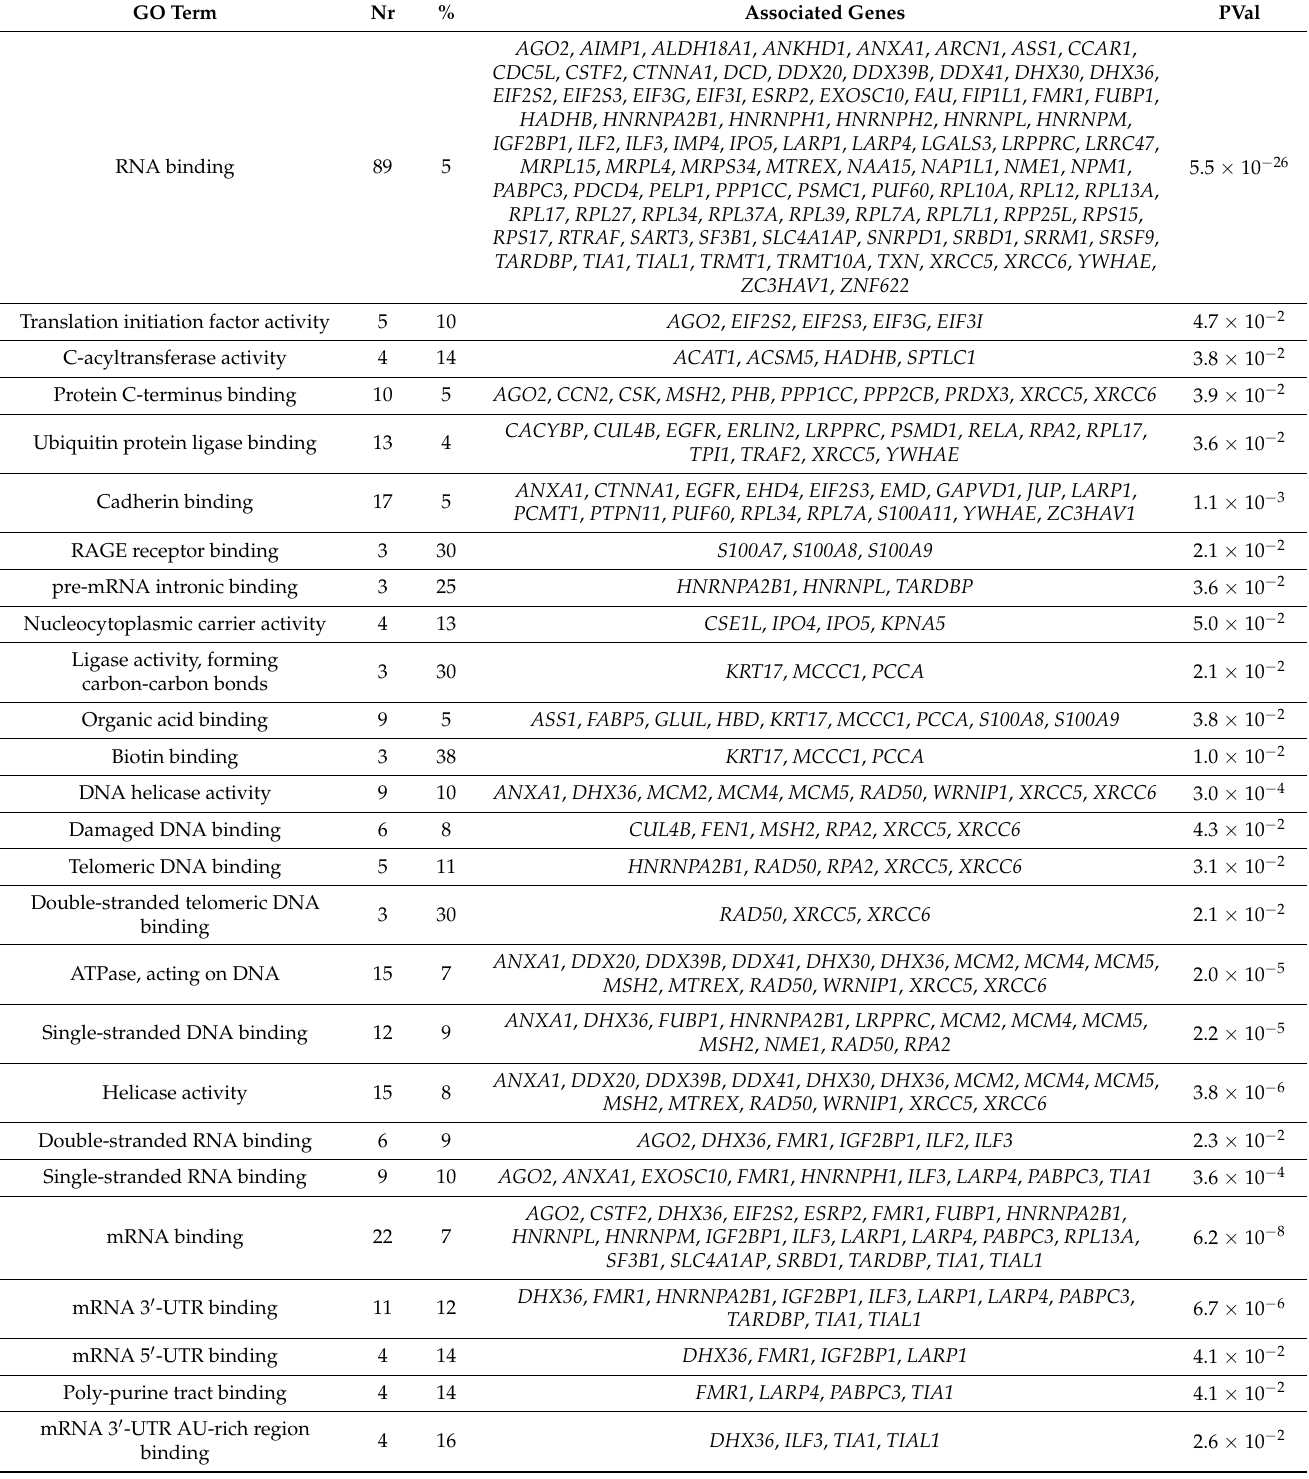
Table 1. Enriched molecular functions of proteins labeled in TIA1-APEX2 reactions. The table provides the results of ClueGO molecular function analysis. Nr: number of genes associated with the GO term. %: genes identified as a proportion of total related genes in GO. PVal: p -value of the GO term after Benjamini-Hochberg